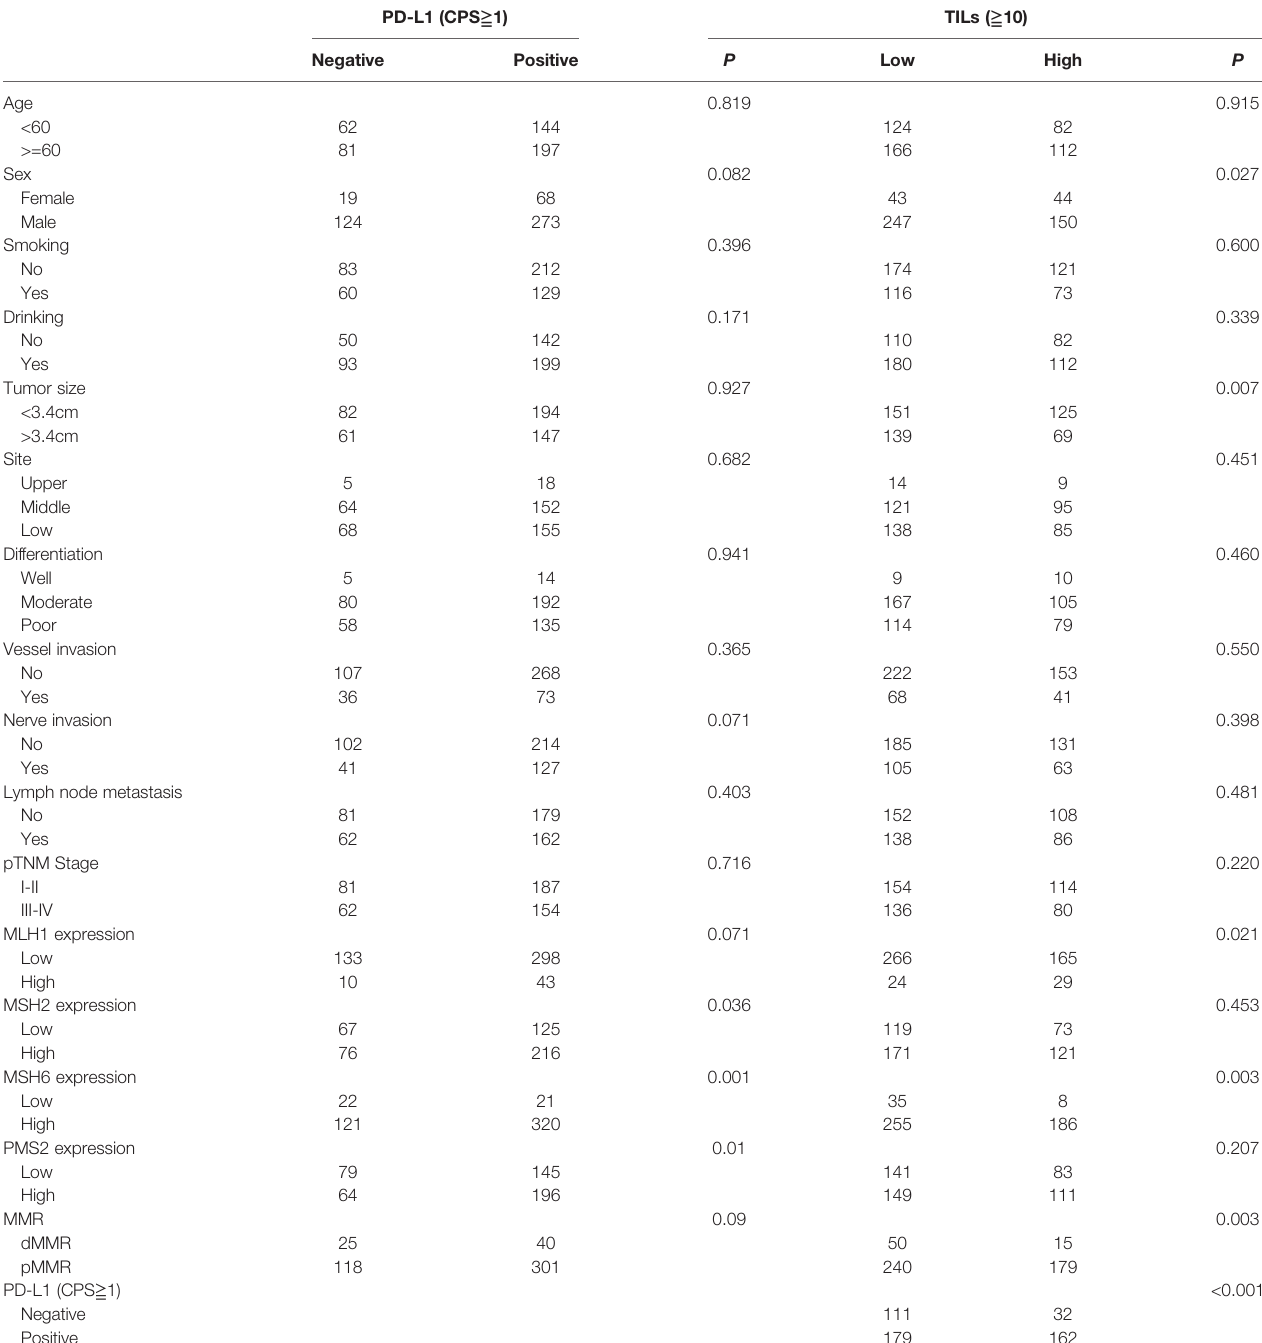
TABLE 3 | Association between PD-L1 expression, TILs, and clinicopathological features of ESCC